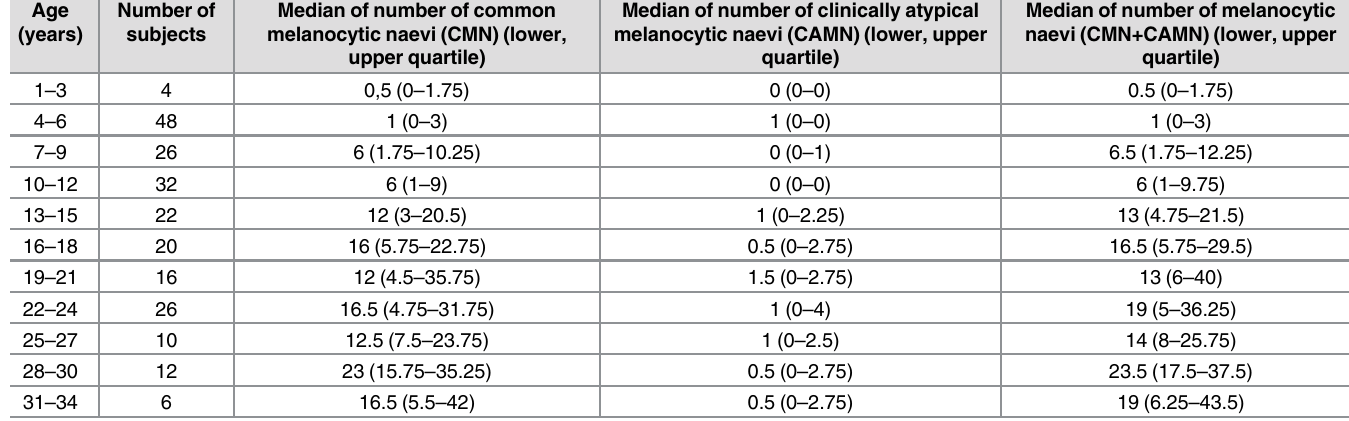
Table 2. Prevalence of common and clinically atypical naevi by age groups among dizygotic twin pairs (N = 222). Age Number of (years)